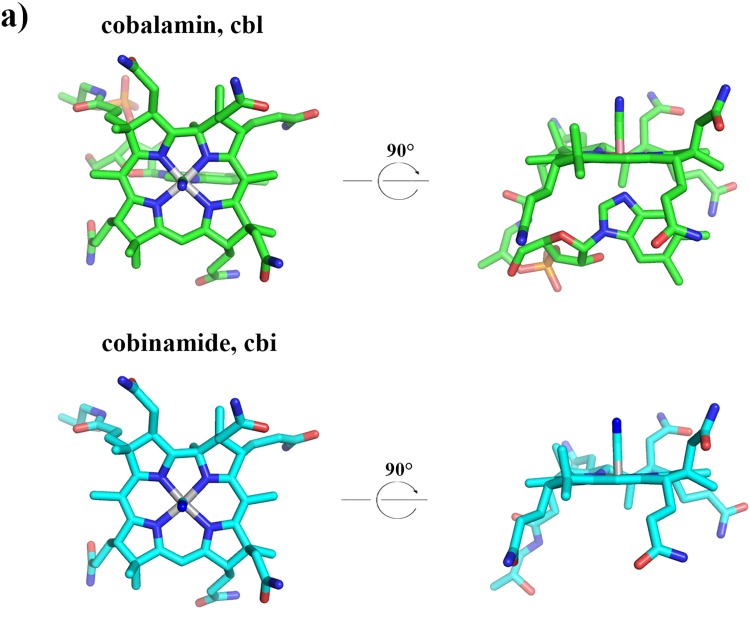
3D structures of cobalamin and cobinamide.Cyanocobalamin (green) and mono-cyanocobinamide (cyan) are shown in stick representation. The central cobalt ion is colored in grey, nitrogen atoms in blue, oxygen atoms in red and phosphate atoms in orange.